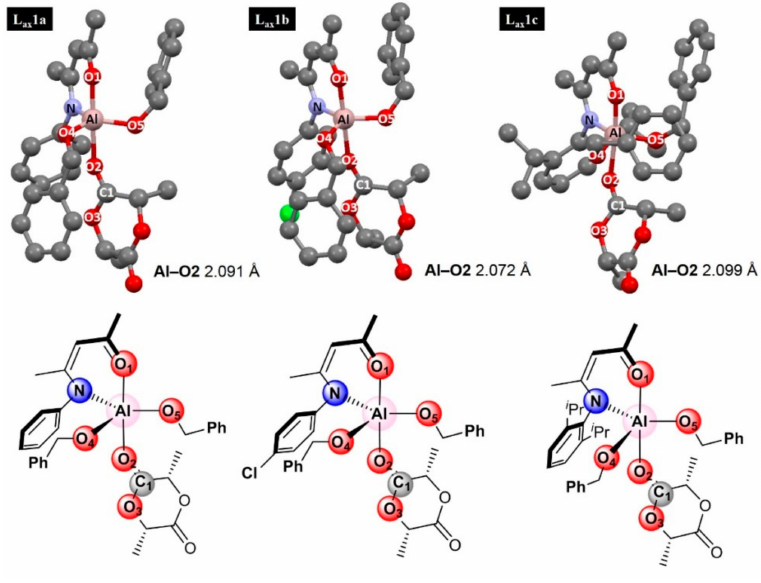
Figure 8. L -lactide coordinated aluminum complexes which bear L, L Cl , and L iPr ligand systems and arrange in a TBP